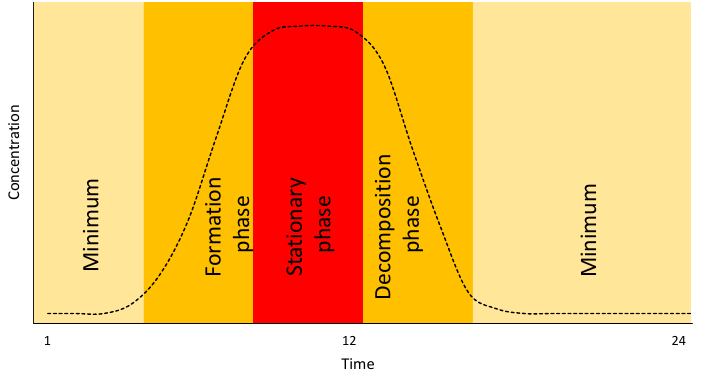
Figure 2. Theoretical daily ozone evolution